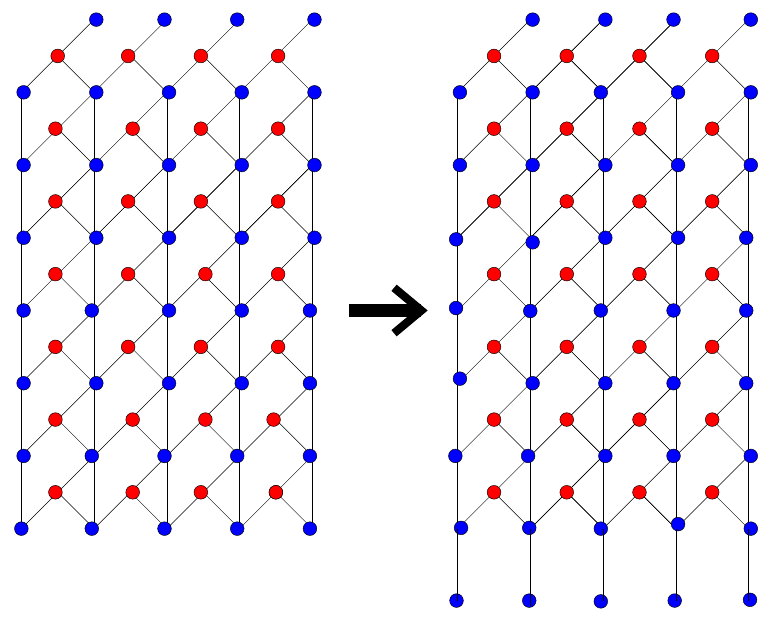
Fig. 6: New graph with only one perfect